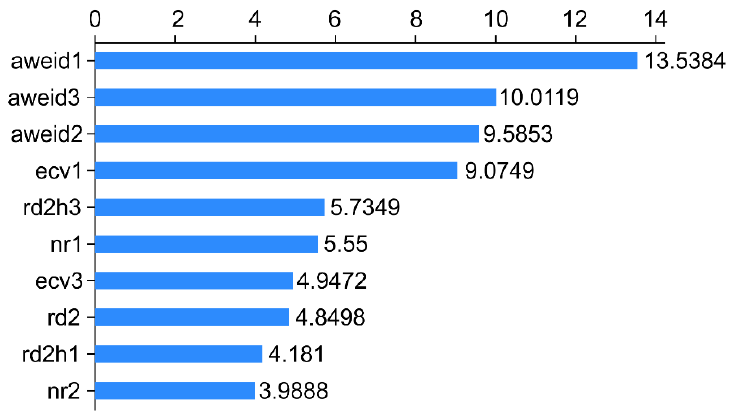
Figure 3. Importance of features for the ten variables in eXtreme Gradient classification.